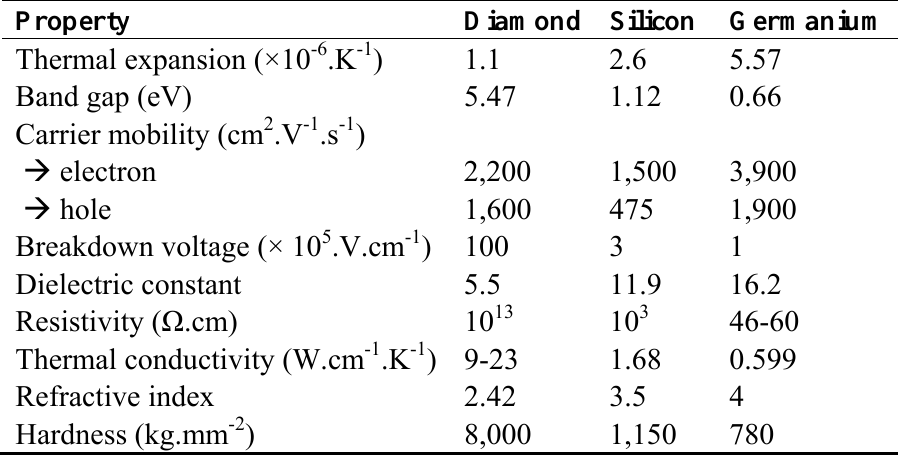
Table 1. Overview comparing the physical properties of three semiconductors: diamond, Si, and